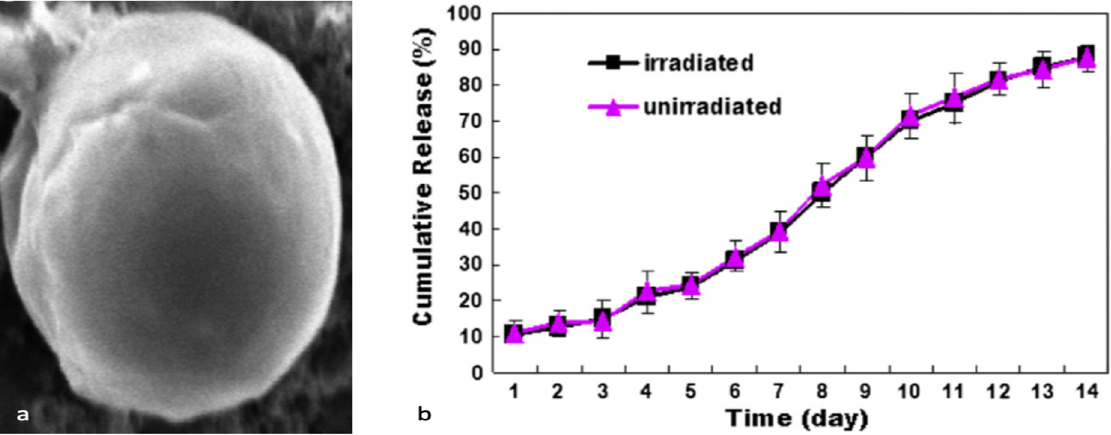
Figure 18. ( a ) SEM micrograph of the developed MTX microspheres and ( b ) in vitro release profiles of MTX from microspheres within 15 days of study [237].